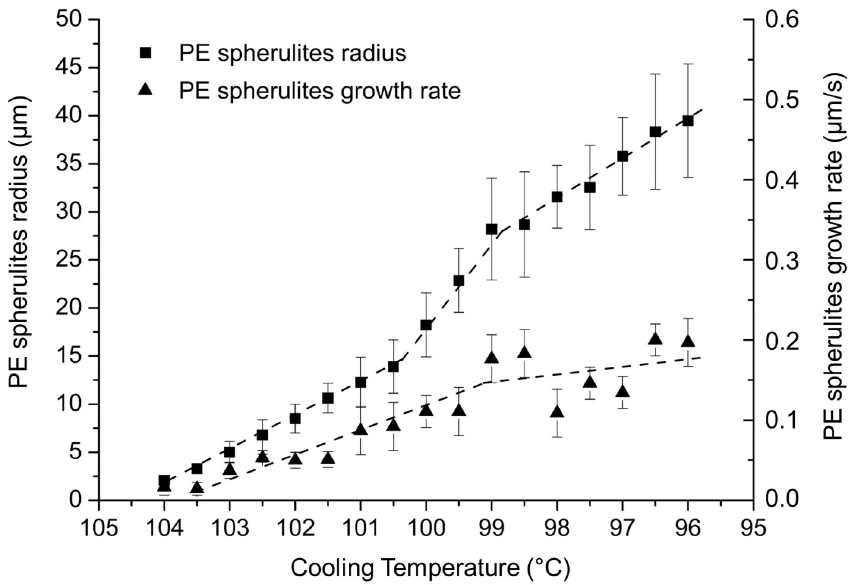
Figure 10. Evolution of the PE spherulite radius and growth rate as a function of the cooling temperature determined by optical